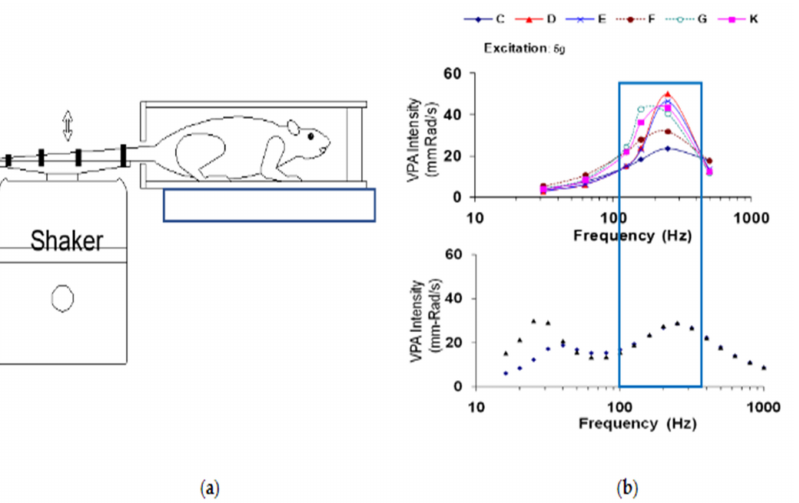
Figure 14. The rat-tail model and the vibration response characteristics of the rat tail on the vibration platform: ( a ) The sketch of the rat-tail vibration exposure system; ( b ) the comparison of the vibration power absorption (VPA) intensity of the rat tail at 6 different points along the length of the tail (points C-K anterior to posterior) for four animals (top figure [205]) with those of the human fingers (bottom figure [75]); they had similar resonant characteristics between 100 Hz and 300